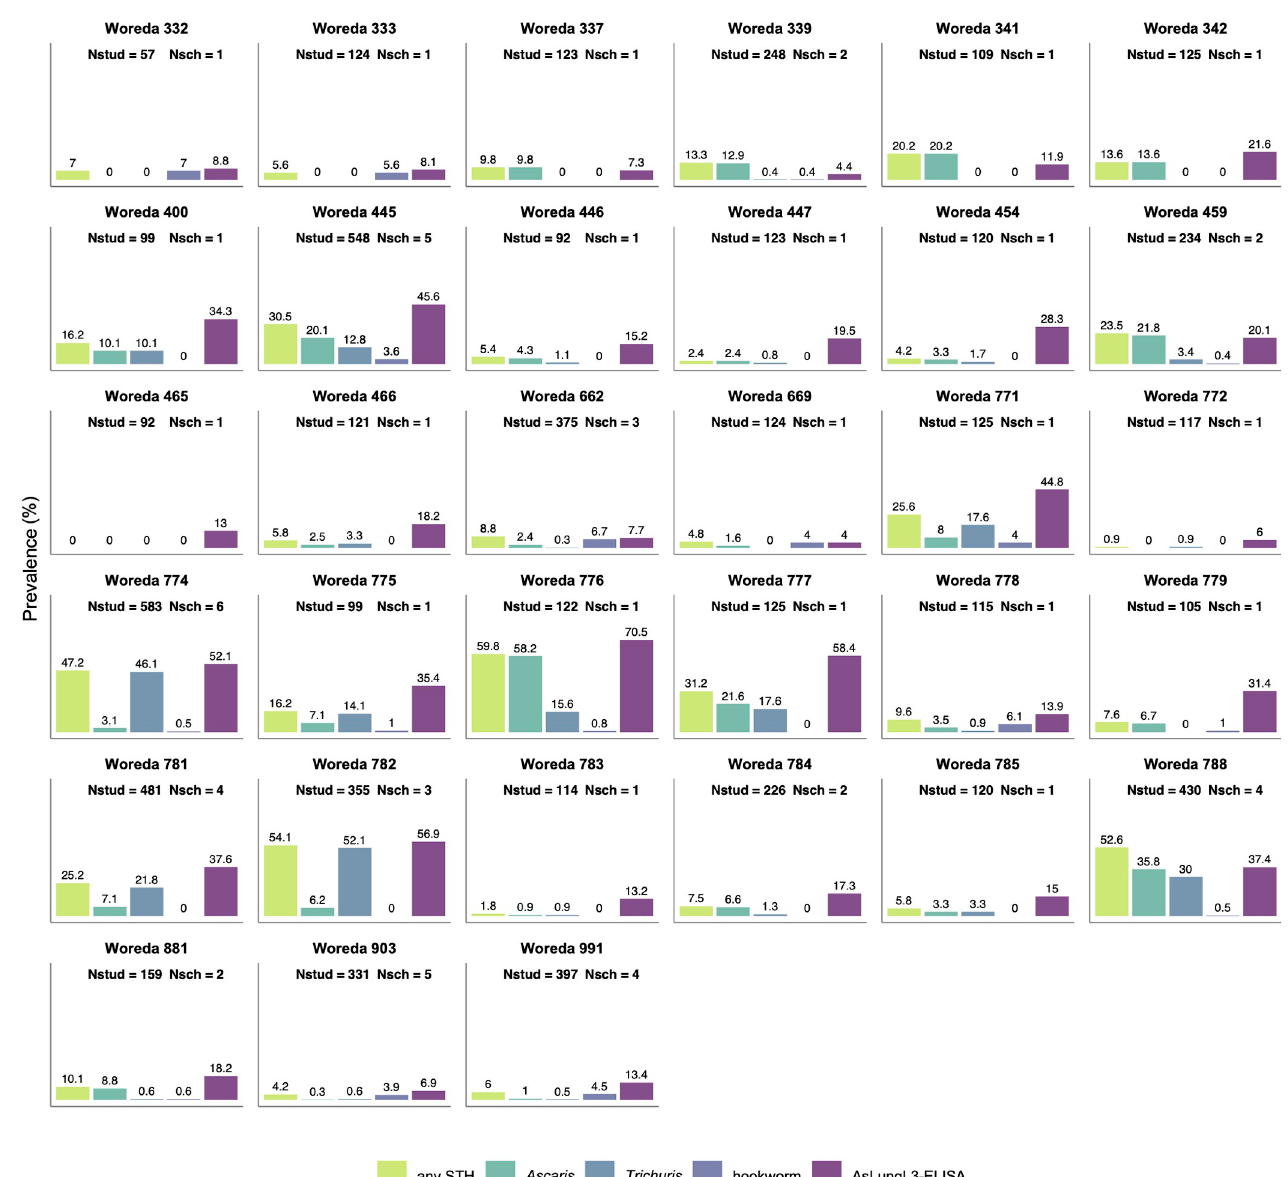
Fig 1. Coproprevalence and seroprevalence of STHs per woreda. The coproprevalence (any STH, Ascaris , Trichuris and hookworm) was calculated as the proportion of students for whom eggs in the stool were detected by Kato-Katz thick smear. The seroprevalence (AsLungL3-ELISA) was defined as the proportion of students with an optical density ratio (ODr) on the AsLungL3-ELISA above the diagnostic cutoff. Nstud: number of students per woreda, Nsch: number of schools per woreda. Samples were collected in woredas of the following 7 regional states: Amhara (woredas 332–342), Oromia (woredas 400–466), Benishangul-Gumuz (woredas 662 & 669), SNNPR (771–788), Gambella (woreda 881), Tigray (woreda 903) and Harari (woreda 991). for further analyses, both variables were calculated for the 33 sampled woredas. The two parameters were highly correlated as indicated in Fig 2 ( ρ 0.96, p-value < 2.2e-16). In a field study in 101 Belgian pig farms, Vlaminck and colleagues observed a similar trend in the rela- tionship between seroprevalence and mean ODr measured by the AsHb-ELISA [24]. Consid- ering this correlation, seroprevalence was chosen as parameter to report serology results in this study, in agreement with the current use of coproprevalence as parameter for coprology. It has